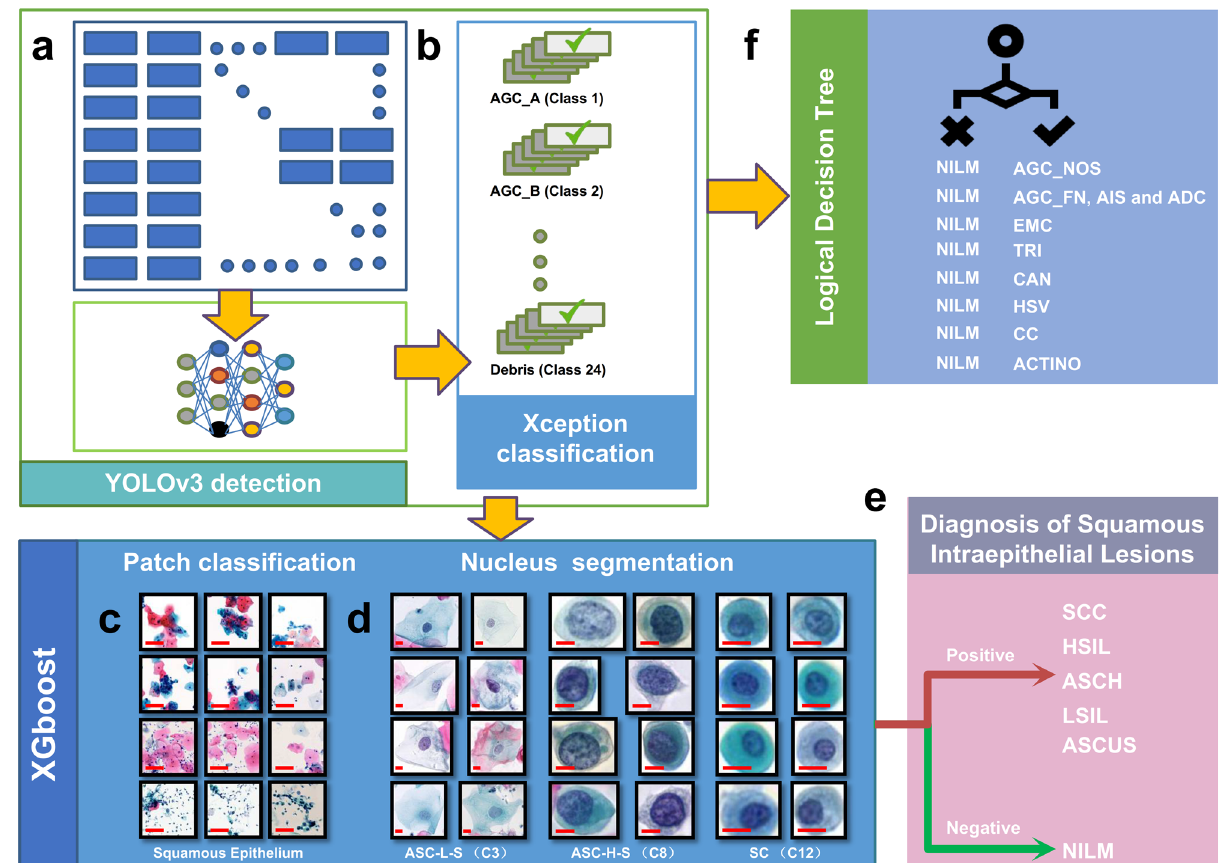
Fig. 4 Diagnostic decision pipeline for TBS classi fi cation and diagnosis. a All digital retrospective smears were detected by the Yolov3 model, and the classi fi cation and probability of the detection targets were extracted. b The Xception model predicted the targets detected by the YOLOv3 model, and then the information of classi fi cation and probability were extracted. c The Patch model was used to extract area classi fi cation and the probability of squamous epithelium targets. (Representative images in Patch model. Scale Bars: 50 μ m). d Nuclear parameter extraction of ASC_L_S, ASC_H_S, and SC (Representative images in nucleus segmentation model. The length of Scale Bars in the images of ASC_L_S are 20 μ m, while 10 μ m in the images of ASC_H_S and SC). e Prediction for TBS classi fi cation of squamous intraepithelial lesions. f Logical Decision Tree was used to predict AGC, EMC, and Infectious